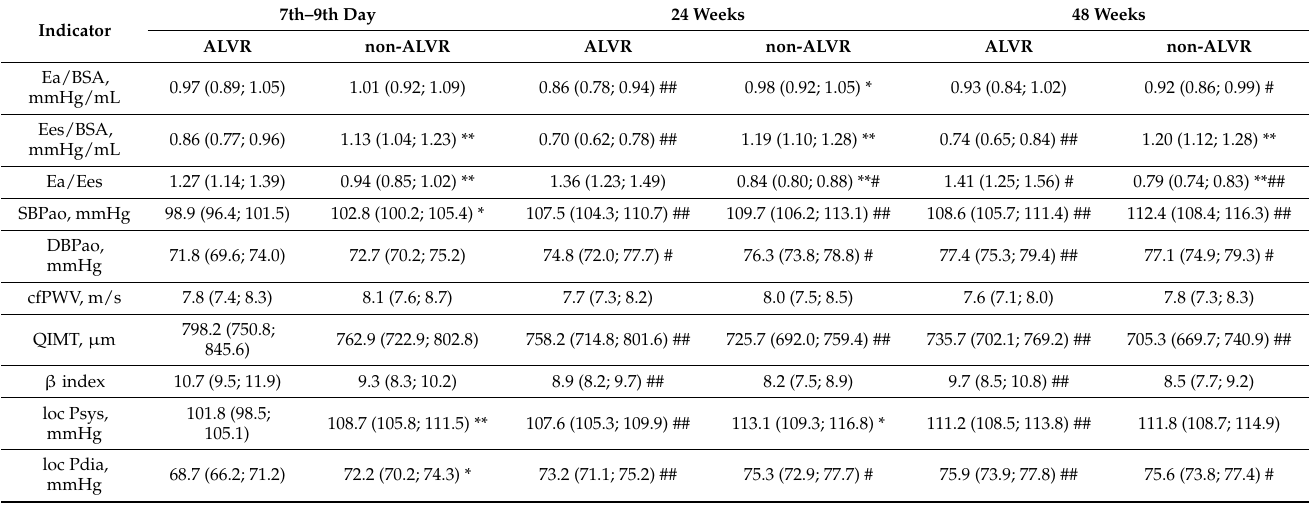
Table 2. Comparative characteristics of LVAC indicators, and structural and functional features of arteries in the comparison